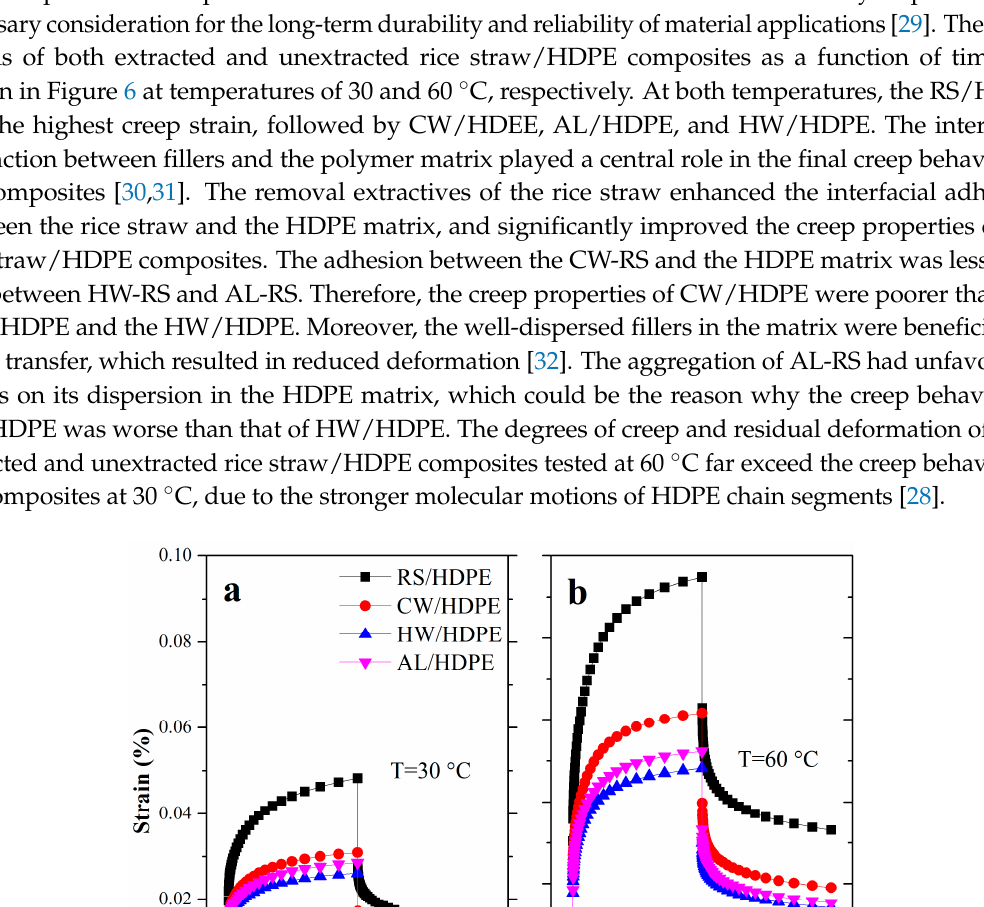
Table 2. Linear coefficient of thermal expansion (LCTE) of the RS/HDPE, CW/HDPE, HW/HDPE, and AL/HDPE measured in the thickness direction at temperatures changing from 30 to 60 °C, 60 to − 30 °C, and − 30 to 30 °C, respectively.